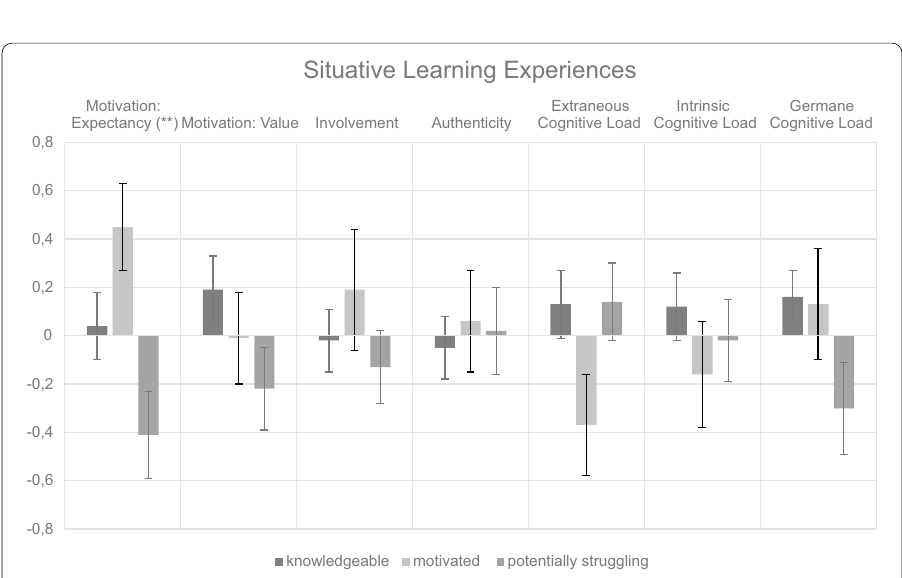
Potentially struggling profile. The third profile ( n